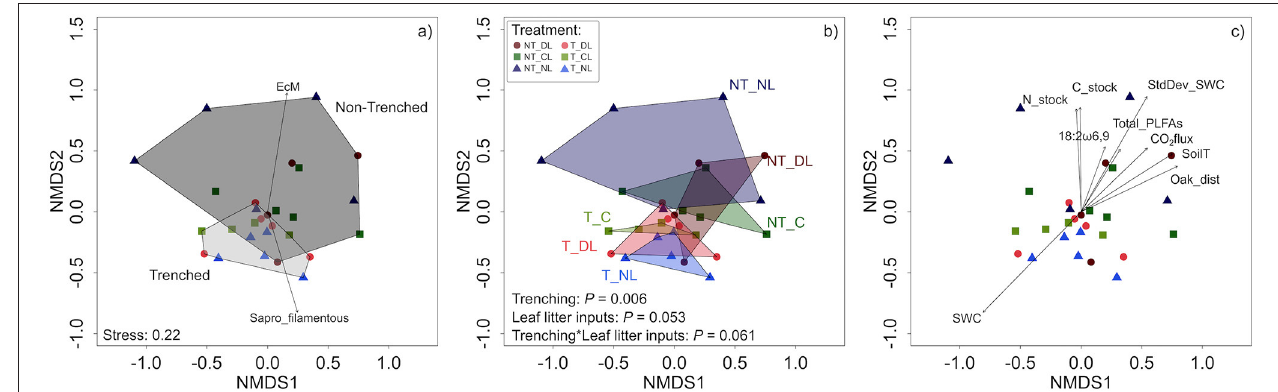
FIGURE 3 | Non-metric multidimensional matrix of soil fungal communities in the trenching and leaf litter inputs treatments. (a) Trenching levels are indicated by shaded polygons and relative abundances of fungal trophic types represented by vectors. (b) Leaf litter levels are indicated by different colored polygons. (c) Gradient direction and strength of environmental variables indicated by vectors. Only variables with a P < 0.05 are shown. EcM, ectomycorrhiza abundance; Sapro_filamentous, filamentous saprotroph abundance; SWC, soil moisture; N_stock, soil N stock; C_stock, soil C stock; 18:2 ω 6,9, 18:2 ω 6,9 PLFA; StdDev_SWC, soil moisture standard deviation; Total_PLFAs, Total PLFAs; CO 2 flux, CO 2 flux; SoilT, soil temperature; Oak_dist, distance to the closest oak tree; NT_DL, Non-Trenched and Doubled Litter; NT_CL, Non-Trenched and Control Litter; NT_NL, Non-Trenched and No-Litter; T_DL, Trenched and Doubled Litter; T_CL, Trenched and Control Litter; T_NL, Trenched and